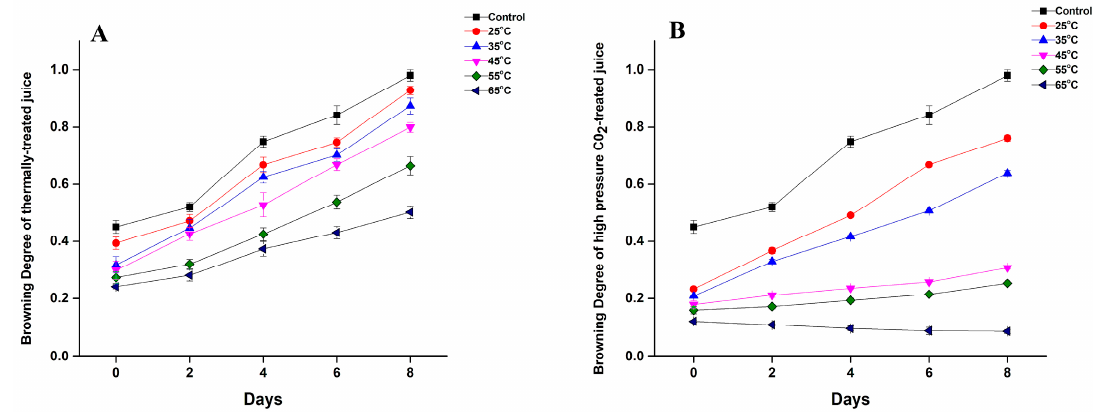
Figure 2. Browning degree during storage at 4 °C ( A ) Thermal treatment; ( B ) HPCD treatment of quince juice at different temperatures.